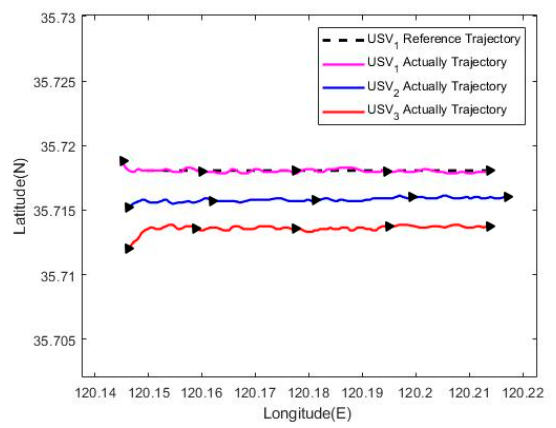
Figure 32. Tracking trajectory of the USV formation.